Question: How would you classify this visualization?
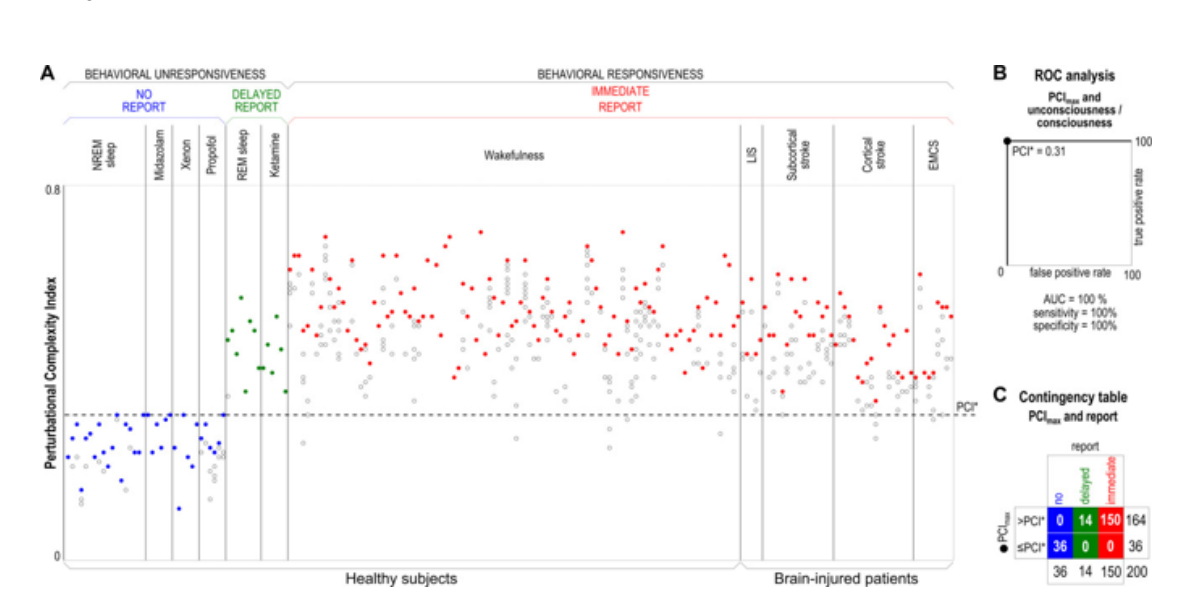
Answer: line